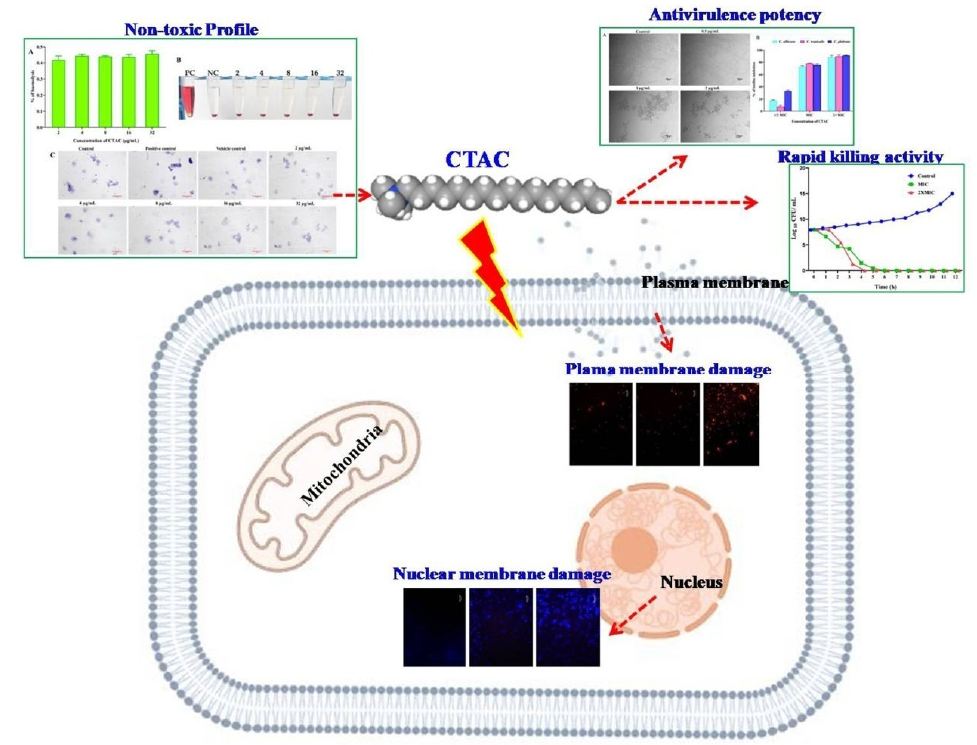
Figure 10. Overview of antifungal modes of action exhibited by CTAC against Candida